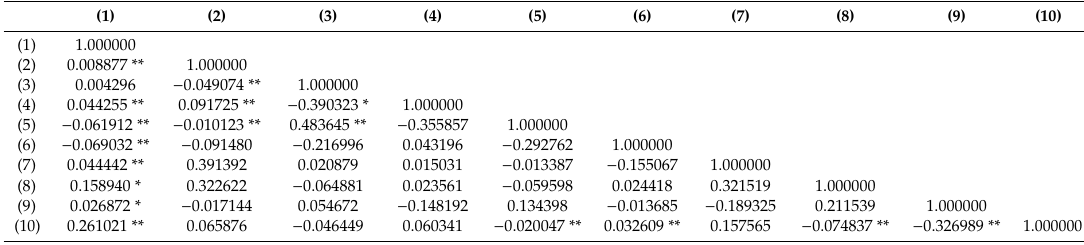
Table 3. Correlation of variables used in the main model.